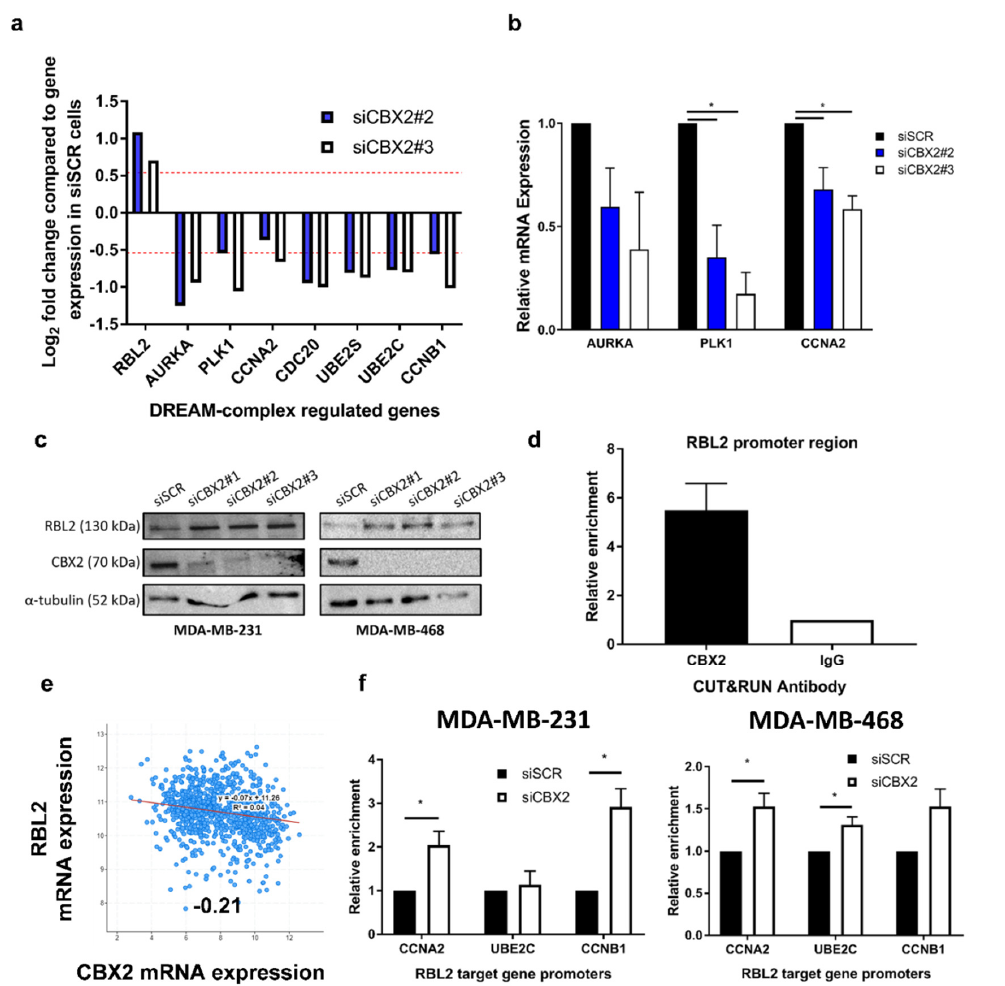
Figure 3 . –CBX2 inhibits expression of the tumour suppressor gene RBL2 to promote cell growth in TNBC. (a) RNA ‐ seq analysis of RBL2 ‐ DREAM complex target genes in MDA ‐ MB ‐ 231 cells trans ‐ fected with siCBX2#2 and #3 compared to siSCR transfected cells (n = 3). Data are presented as log 2 fold change in expression. The red line represents a 1.5 ‐ fold increase or decrease in expression com ‐ pared to siSCR transfected cells. All genes are significantly differentially expressed in CBX2 de ‐ pleted cells compared to siSCR transfected cells (padj < 0.05). ( b ) MDA ‐ MB ‐ 468 cells were trans ‐ fected with either a non ‐ silencing control siRNA (siSCR) or siCBX2#2/#3 and grown for 72 h, fol ‐ lowed by RNA extraction and qPCR analysis of RBL2 ‐ DREAM complex target genes. qPCR data are an average of 3 repeats ± SEM and are expressed relative to gene expression in siSCR transfected cells. p ‐ values were determined by Student’s t ‐ test comparing CBX2 depleted cells to siSCR trans ‐ fected cells (* denotes p < 0.05). ( c ) MDA ‐ MB ‐ 231 and MDA ‐ MB ‐ 468 cells were transfected with siRNA and grown for 72 h, followed by protein extraction and Western blot analysis using antibod ‐ ies specific to RBL2, CBX2 and α‐ tubulin. α‐ tubulin was used to compare protein loading between samples. ( d ) CUT&RUN qPCR analysis of the promoter region of RBL2 in MDA ‐ MB ‐ 231 cells using antibodies specific to CBX2 and isotype control (IgG). Data are an average of 2 independent exper ‐ iments ± SEM and are expressed relative to the level of enrichment measured in the IgG control. ( e ) Correlation of CBX2 and RBL2 gene expression in the TCGA, PanCancer Atlas Breast Invasive Car ‐ cinoma data set. Value = Spearman co ‐ efficient. p < 0.05. ( f ) ChIP ‐ qPCR analysis of RBL2 ‐ DREAM complex target gene promotors in MDA ‐ MB ‐ 231 and MDA ‐ MB ‐ 468 cells transfected with either siSCR or a siCBX2 targeting pool using an antibody specific to RBL2. Data are an average of 3 inde ‐ pendent experiments ± SEM and are expressed relative to the level of enrichment measured in the siSCR transfected cells. p ‐ values were determined by Student’s t ‐ test comparing CBX2 depleted cells to siSCR transfected cells (* denotes p <